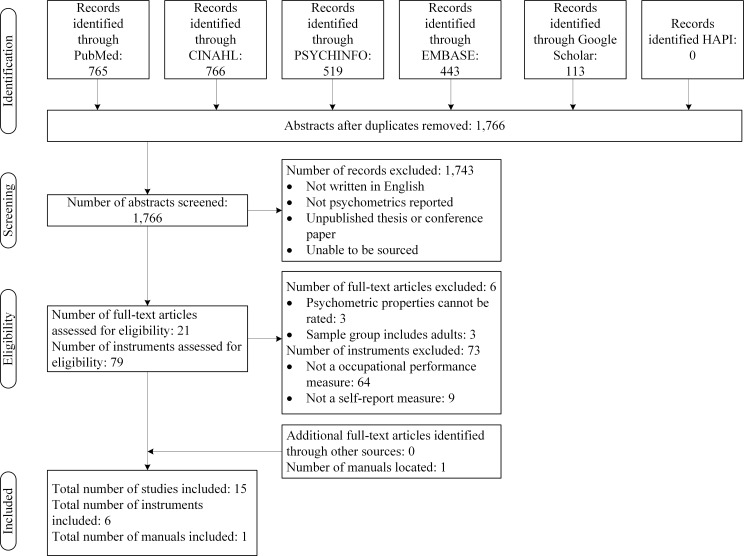
Flowchart of included studies, manuals and measures.